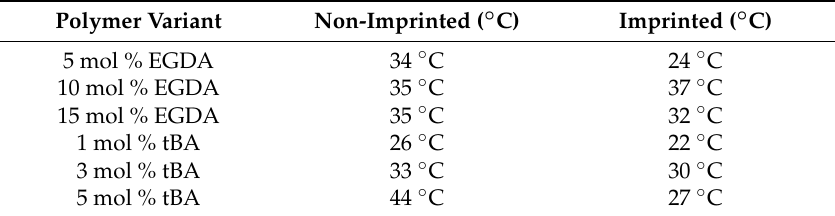
Table 1. Duration of T g in variable tBA and crosslinker polymers. Polymer